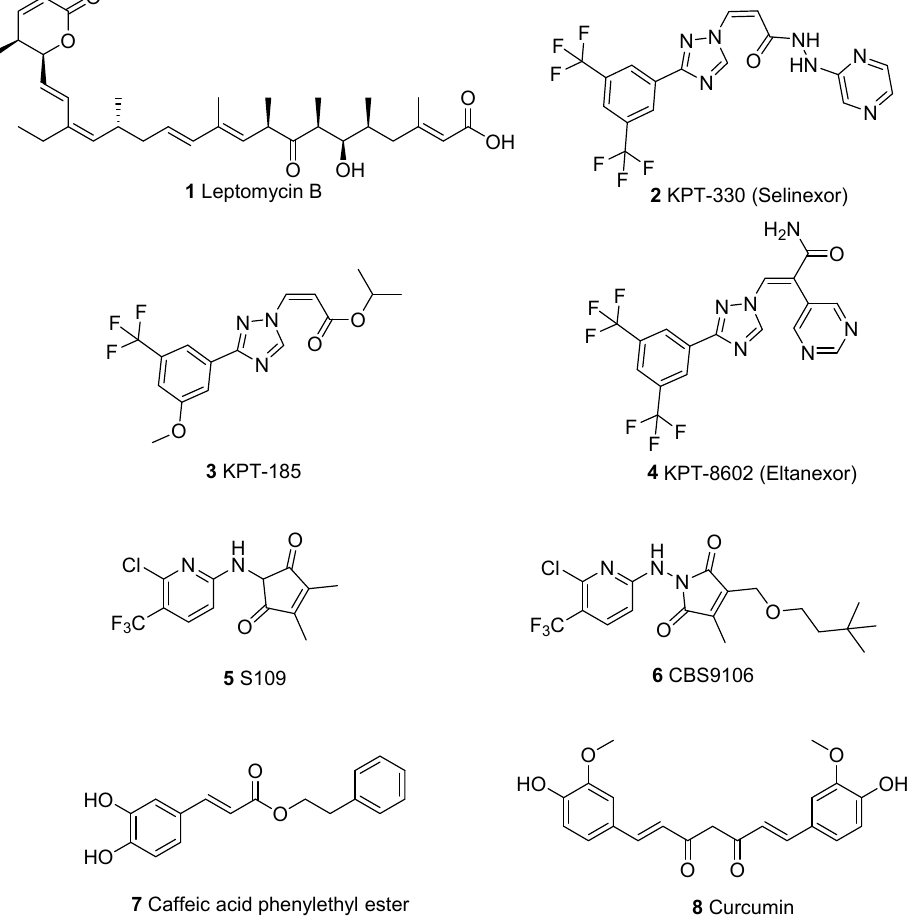
Figure 1. Chemical structures of several XPO1 inhibitors. The overall structure of XPO1 complexed with Ran and RanBP1 is shown in Figure 2A, where the NES-binding cleft is colored in grey. Structurally, this cleft contains five